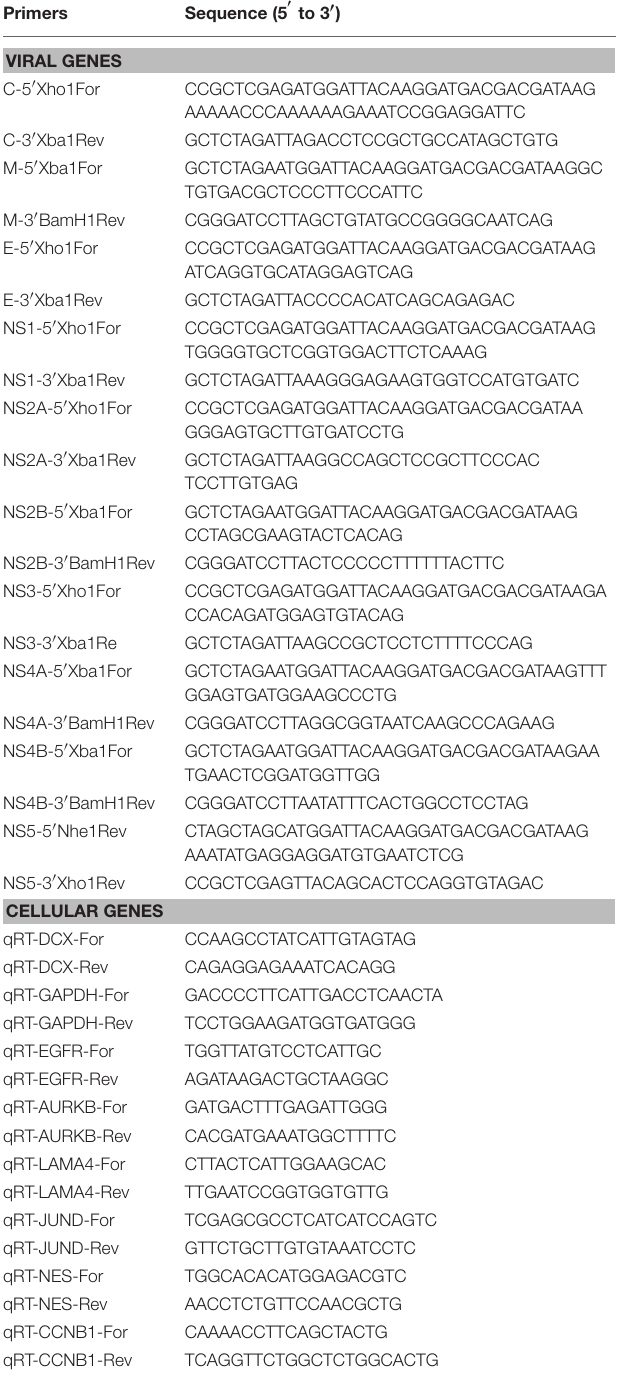
TABLE 1 | Primers for amplification of the viral and cellular